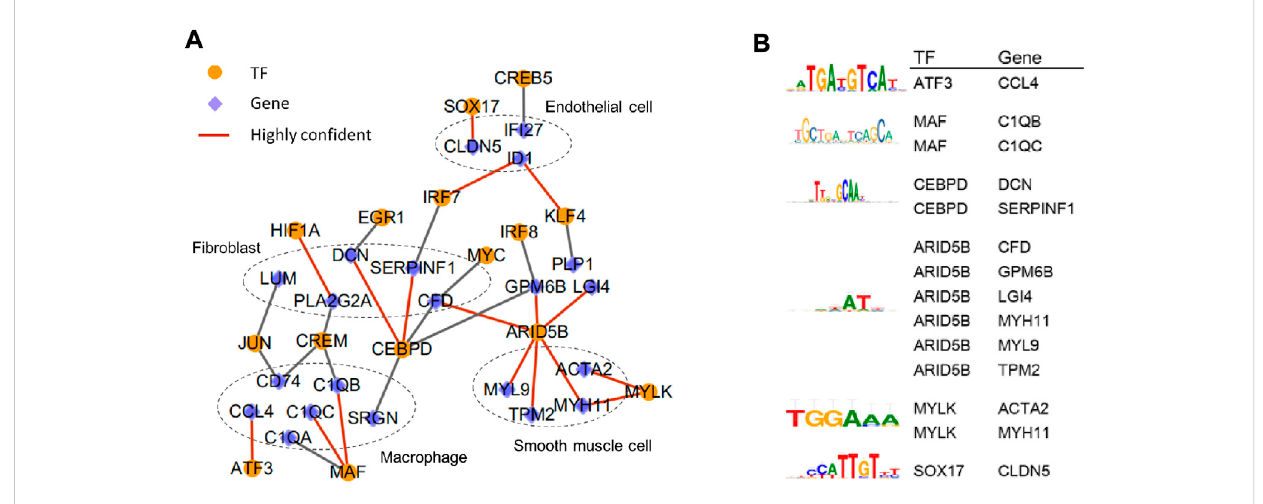
FIGURE 3 In-depth analysis of the correlation between various types of cells in human atherosclerotic coronary arteries. (A) Transcription factor-target gene network.Highlycon fi dentTFsandtargetgenesarelinkedwithredline. (B) Thebestbindingmotifofhighlycon fi dentTFsandtargetgenes.Thedataofthis fi gure is from